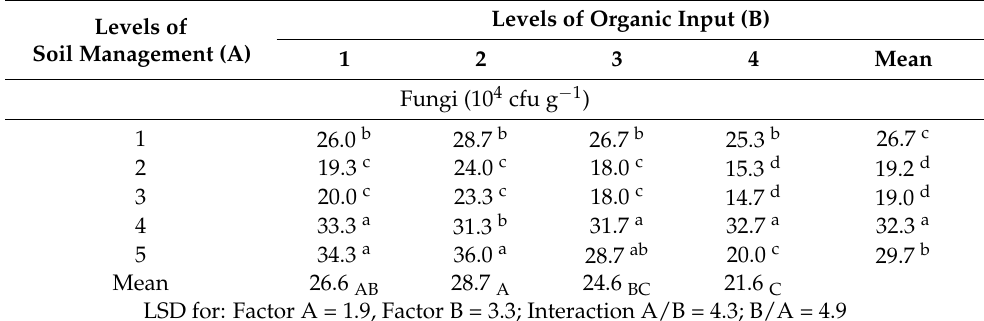
Factor A levels: 1—post-harvest: grubber with a roll; pre-sowing: grubber + seeder-cultivator unit, 2—post- harvest: grubber with a roll; sow ploughing + seeder-cultivator unit, 3—single ploughing + seeder-cultivator unit, 4—post-harvest: manure + grubber with a roll; pre-sowing: sow ploughing + seeder-cultivator unit, 5—direct sowing; Factor B levels: 1—leaving the shredded straw, 2—leaving the shredded straw + EM, 3—removing the